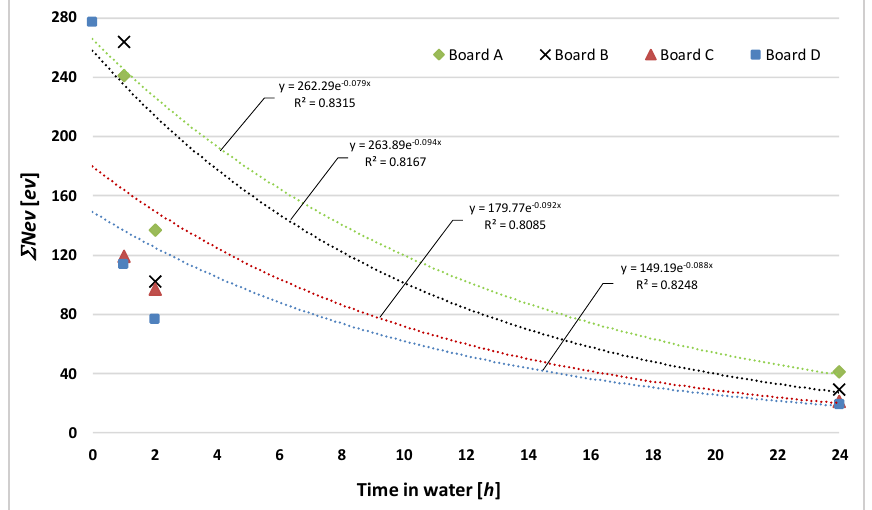
Figure 11. Count of acoustic emission (AE) events recognized as accompanying rupture of fibers for fiber cement boards of series A, B, C, and D versus time of storage in water.